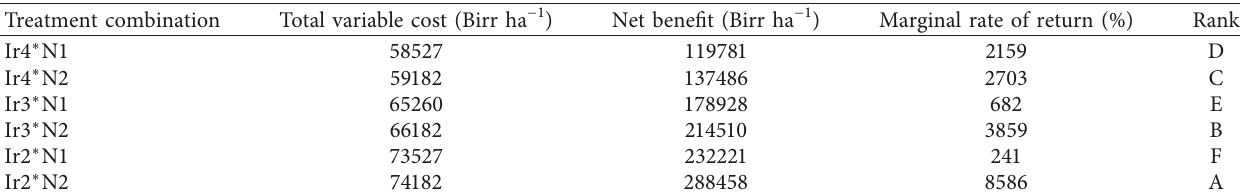
Table 9: Marginal rate of return (MRR) in respect of irrigation and fertilizer N levels on marketable yield of onion. Treatment